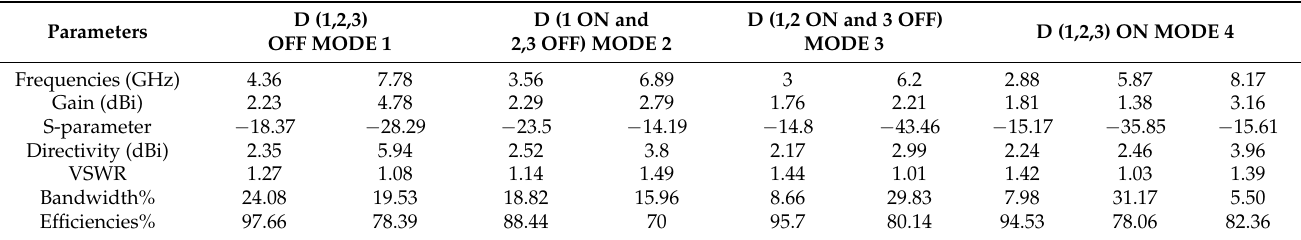
Table 3. Summary of antenna